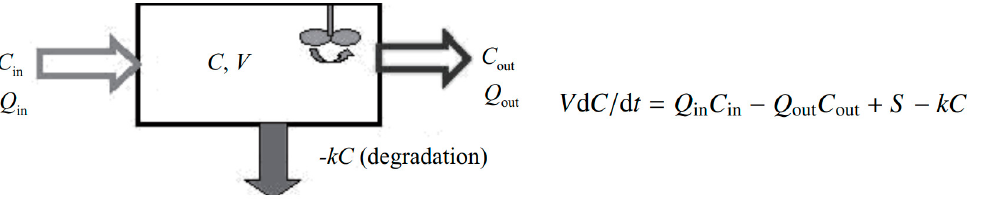
Figure 5. Schematic diagram of a fully mixed box model. C in , C and C out are concentrations of the monitored gas in the inflow, indoor air and outflow, respectively, Q in , Q out are air flows into/out of the building/space V is room volume [32].